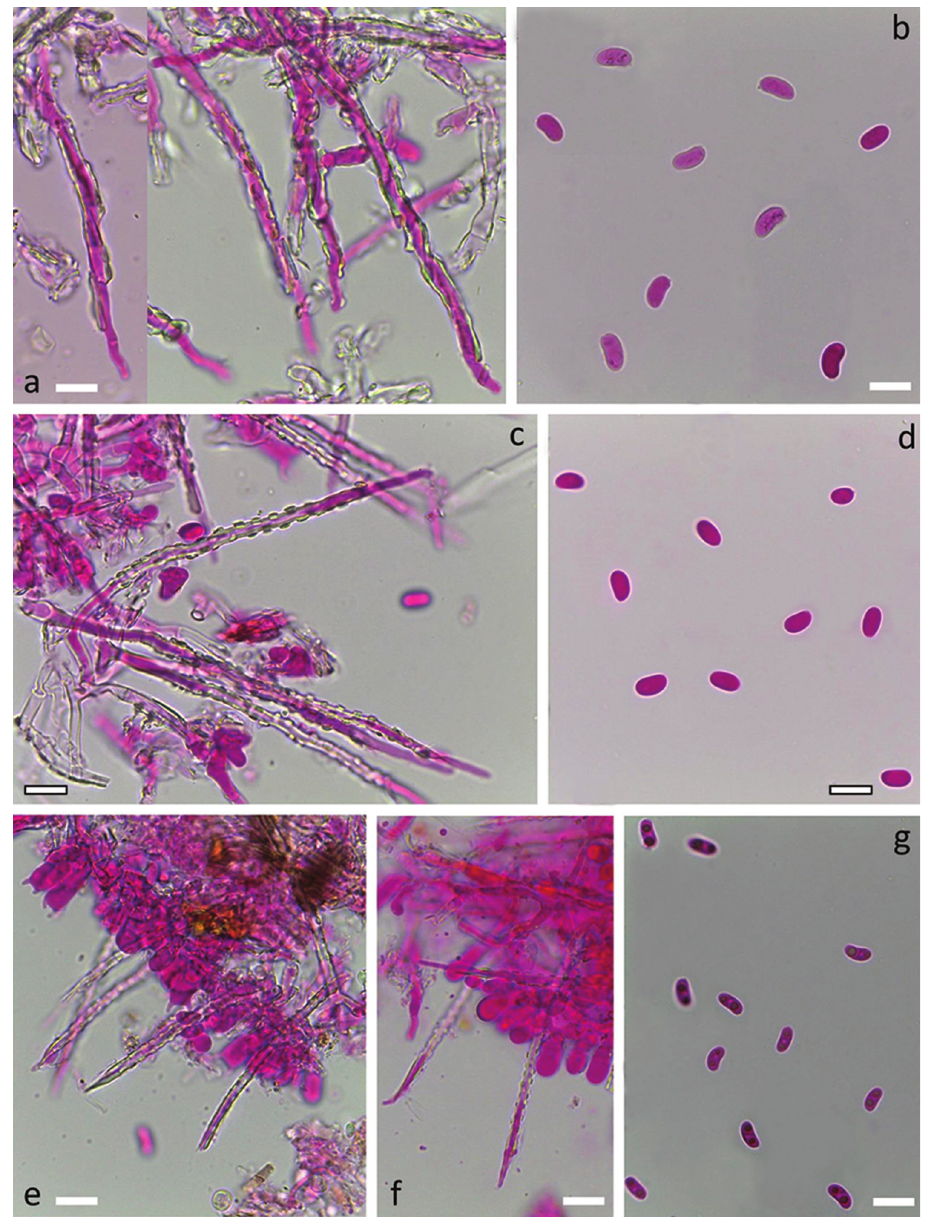
Figure 5. Species of Subulicystidium with broad cylindric basidiospores. Subulicystidium oberwinkleri (KAS:L 1860, holotype): a cystidia b basidiospores. Subulicystidium nikau (KAS:L 1296): c cystidia d ba- sidiospores. Subulicystidium boidinii (KAS:L 1584a, holotype): e mature hymenium f young hymenium g basidiospores. All preparations done in 3% aqueous solution of potassium hydroxide (KOH) mixed with 1% aqueous solution of Phloxine. All scale bars equal 10